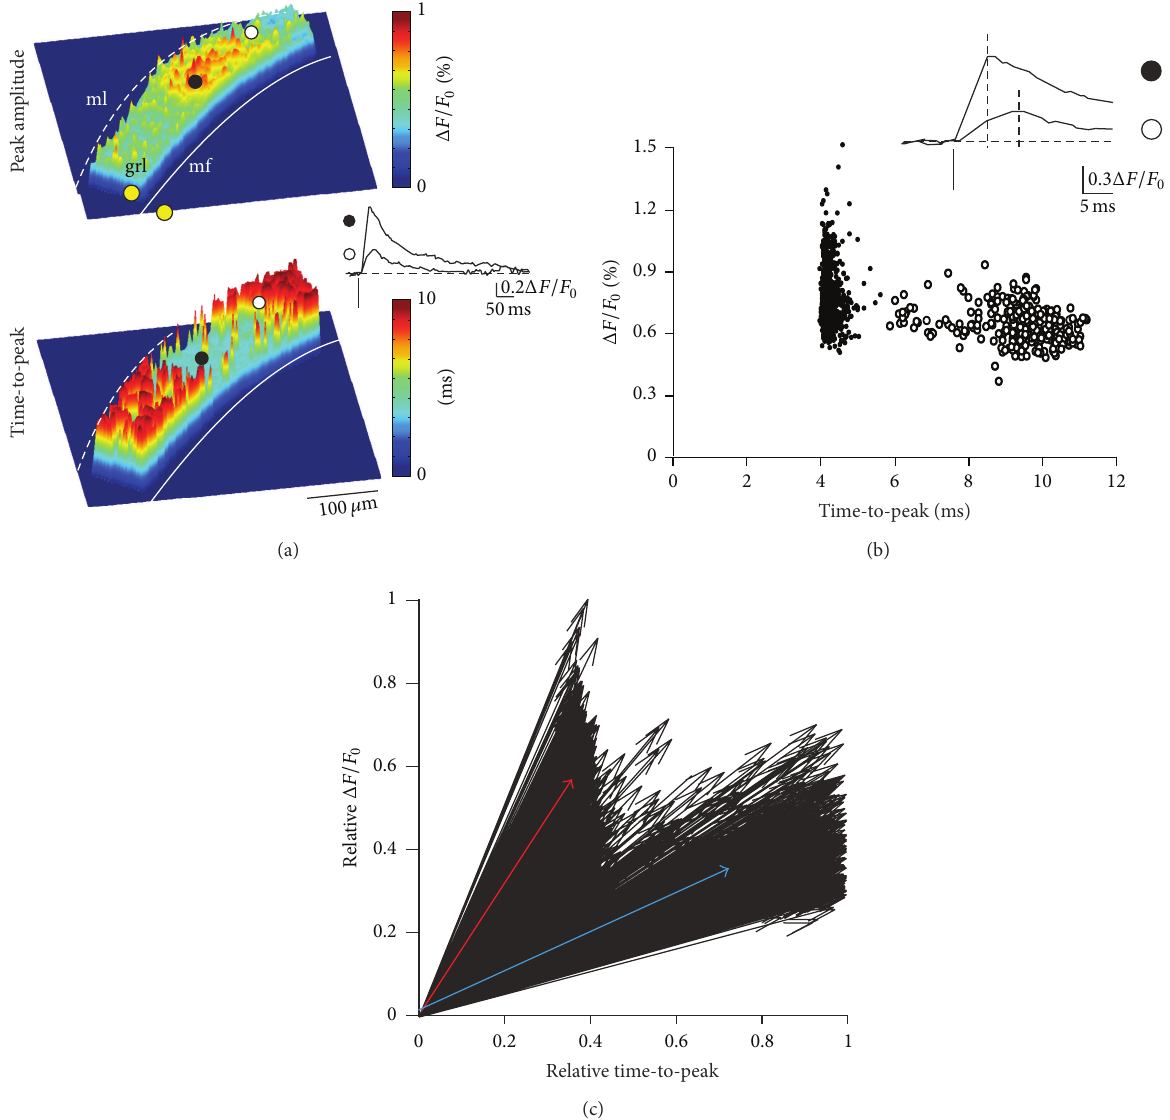
Figure 2: Vector representation identifies two populations of VSD signals in the cerebellar granular layer. VSD imaging of granular layer activity in a rat parasagittal slice. In this and in the following figures mf = mossy fibers (continuous white line); grl = granular layer; ml = molecular layer; dashed white lines = Purkinje cell layer; yellow dots = stimulation electrodes. (a) Top . Activation map of the granular layer in response to a single pulse delivered to a mossy fiber bundle, in which pseudocolors represent response peak amplitudes. Bottom . Time-to- peak map for the same signals reported above (top). Traces illustrate time courses obtained from a region (filled circle) in which responses show large peak amplitude and short delay and a region (empty circle) with responses showing small peak amplitude and long delay. (b) The plot shows the Cartesian relationship between time-to-peak andpeak amplitude for the same experiment shown in (a). PCA analysis made it possible to distinguish between two groups of responses (filled and empty circles), which corresponded to the categories of signals observed in (a) and shown in the inset . (c) Signals shown in (b) were normalized for both peak amplitude and time-to-peak and represented as vectors. The thick blue vector results from averaging the empty circles in (b), while the thick red vector results from averaging the filled circles in